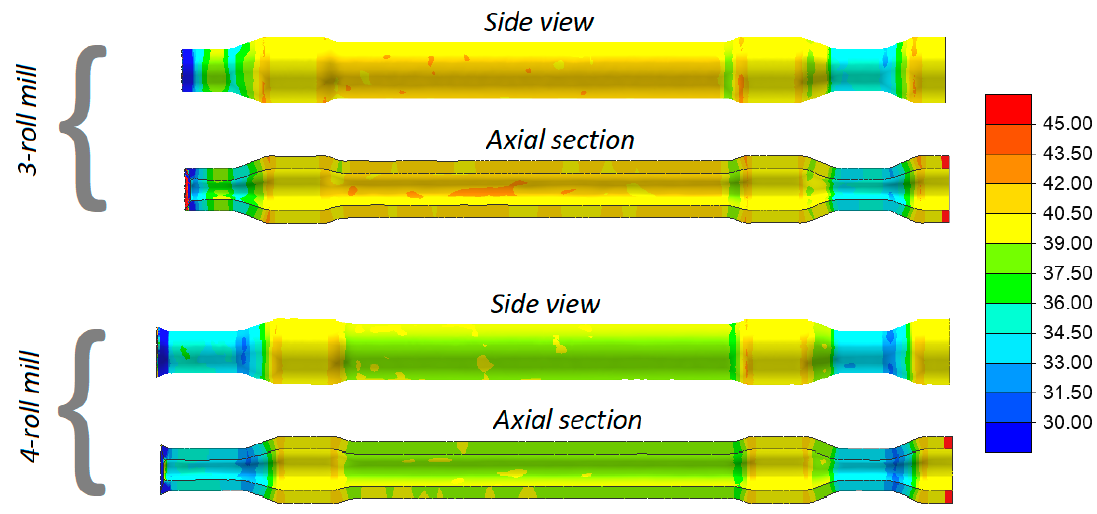
Figure 14. Wall thickness (given in mm) in skew-rolled hollow axles.